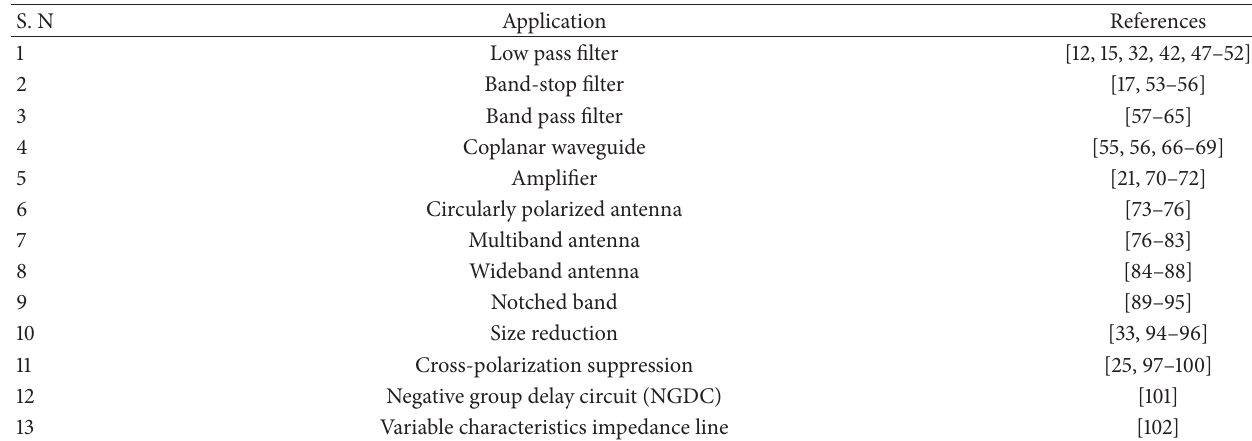
Table 4: Summary of applications of DGS in microwave